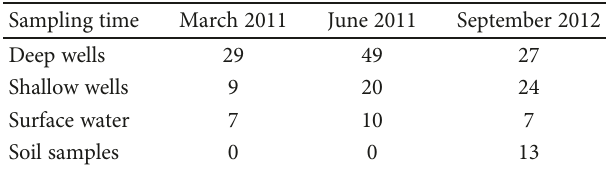
Figure 2: Hydrogeologic pro fi le of the region near the Hun River. Modi fi ed from Hou et al. [16]. Table 1: Sampling conditions in di ff erent